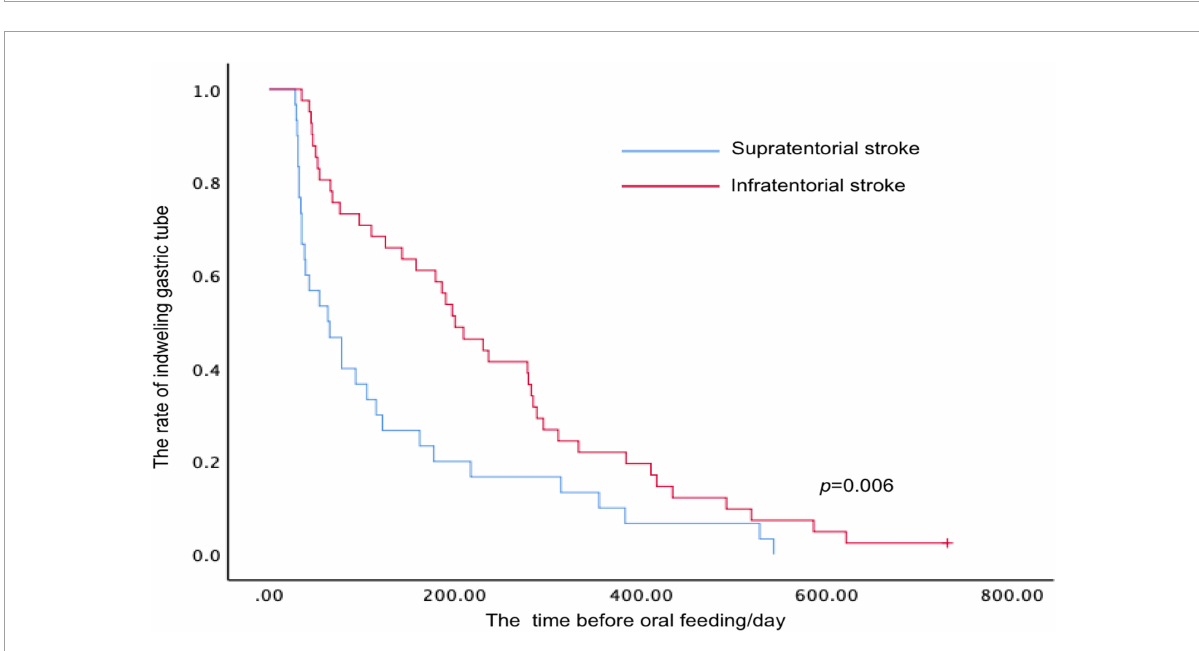
FIGURE4 Kaplan–Meier analysis for time-to-event end points (oral feeding with a necessity for the modification of food consistency) stratified by the lesion sites after